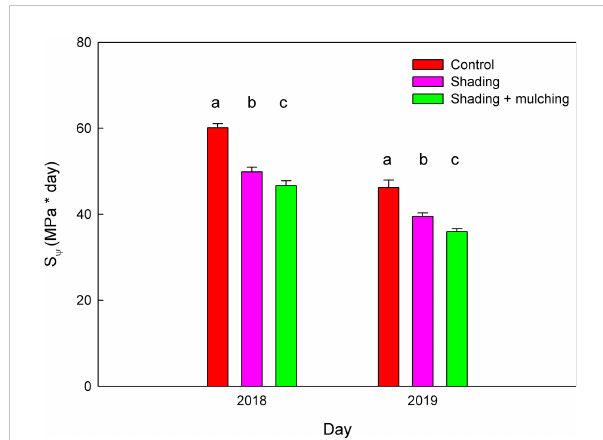
FIGURE 3 Values of the water stress integral (S Y ) during the period from veraison to harvest during the 2018 and 2019 seasons for Macabeo grapevines subjected to different management strategies. Data are the average and standard errors of eight measurements per date and season (n = 24). Different letters mean a signi fi cant difference among treatments within each season (Duncan test; p <